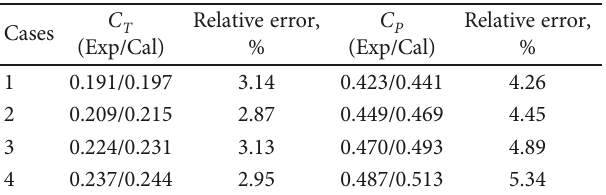
Table 2: Detailed results of the wind tunnel test and URANS numerical